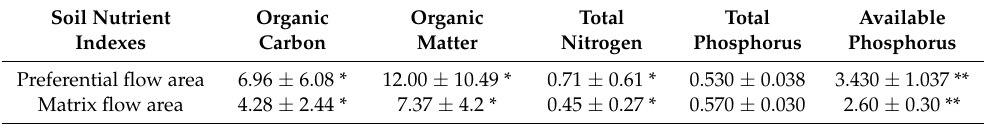
Table 2. Content of soil nutrients in different areas.